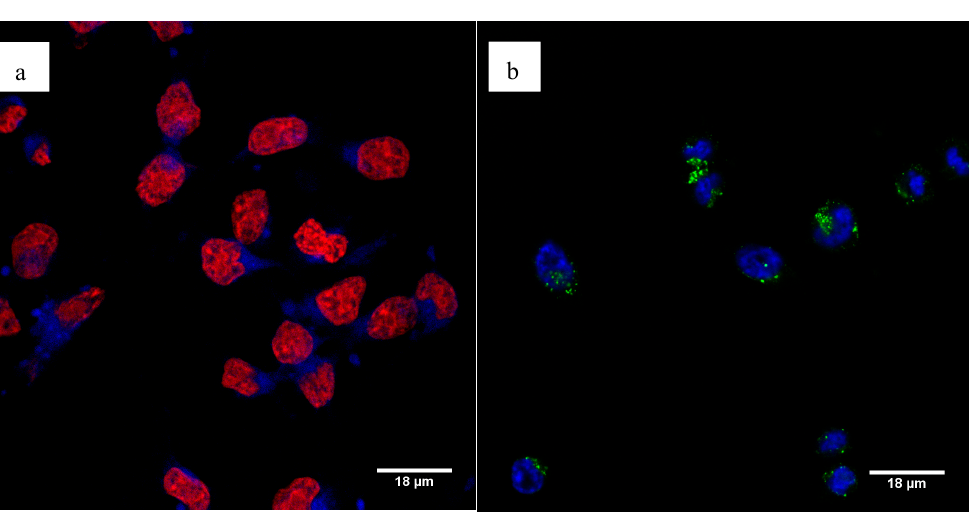
Figure 8. Cellular uptake of fluorescent Pt-PEI30 compounds was visualized by confocal microscopy after 3h30 treatment on HCT116 cells. ( a ) Cells were treated with Pt-PEI30-Coumarin conjugate (in blue) and cell nucleus was stained using DRAQ5 (in red), ( b ) cells were treated with Pt-PEI30-FITC conjugate (in green) and cell nucleus was stained with Hoechst 33342 (in blue).